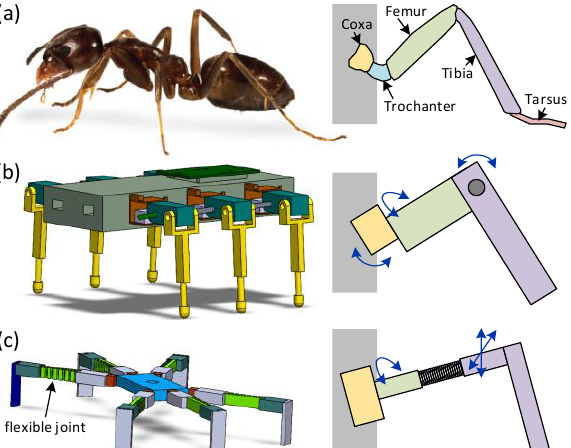
Figure 1. Comparison of six-legged insect and robot: ( a ) a biological six-legged ant and schematics of its hinder leg, ( b ) schematics of a rigid hexapedal robot and the structure of rigid leg with motors, and ( c ) schematics of a hybrid soft hexapedal robot and the structure of its hybrid soft leg with a motor and a spring. The same colors in 2D diagram represent the same segments of the leg (some segments in a biological insect leg are excluded in a robot leg). The blue arrow and the gray column at coxa joint in 2D diagram represent the direction of motion and the body, respectively.